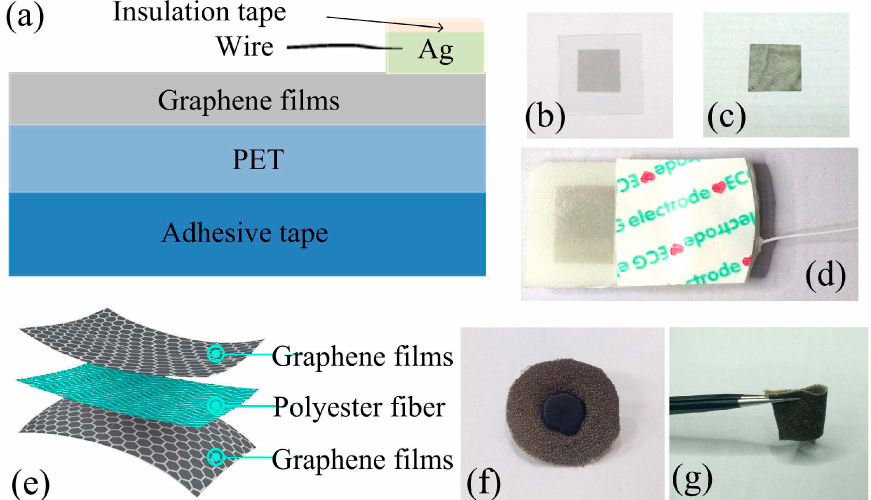
Figure 9. ( a ) Schematic of flexible graphene electrodes; ( b , c ) photos of graphene–polyethylene terephthalate (PET) and a graphene paper; ( d ) assembled graphene electrodes; ( e ) schematic of graphene textile consisting of graphene films and polyester fibers; ( f , g ) photos of graphene textile electrodes [125]. Reprinted with permission. Copyright (2018)